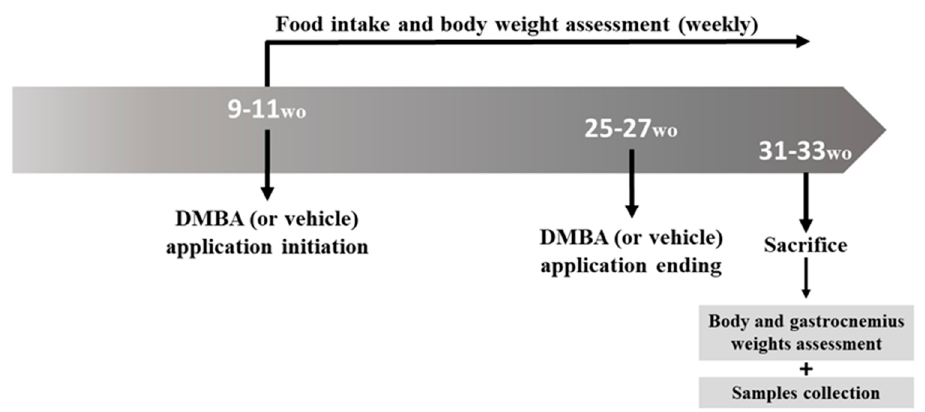
Figure 11. Experimental design timeline. Weekly DMBA application (0.031 mg/animal/week in 4 μ L of DMSO) started at 9–11 weeks of age, lasting for 17 weeks. Groups 2 and 4 received DMBA, while Groups 1 and 3 received DMSO only (the vehicle). Animals were sacrificed at 31–33 weeks of age for sample collection. wo: weeks